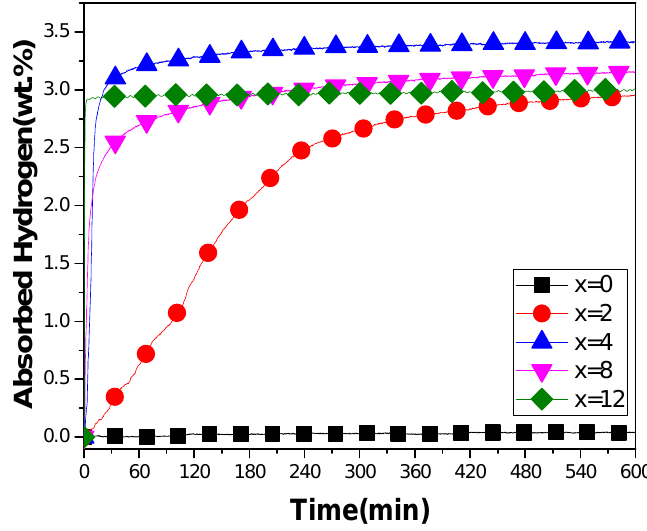
Figure 4. Activation curves of: Ti 1 V 0.9 Cr 1.1 + x wt % Zr for x = 0, 2, 4, 8, and 12 at room temperature under 2MPa of hydrogen.